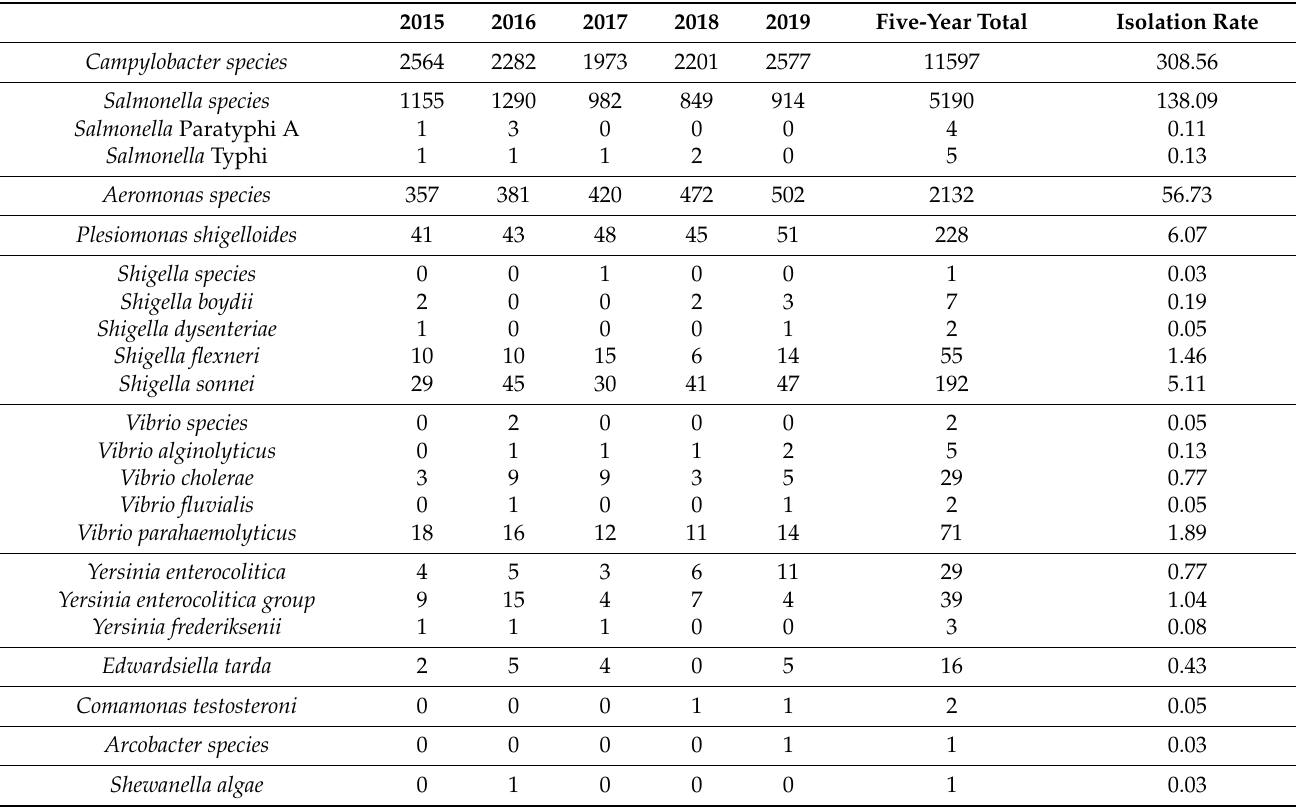
Table 1. Isolation of bacterial pathogens from faecal samples of patients with gastroenteritis in years 2015–2019 *.